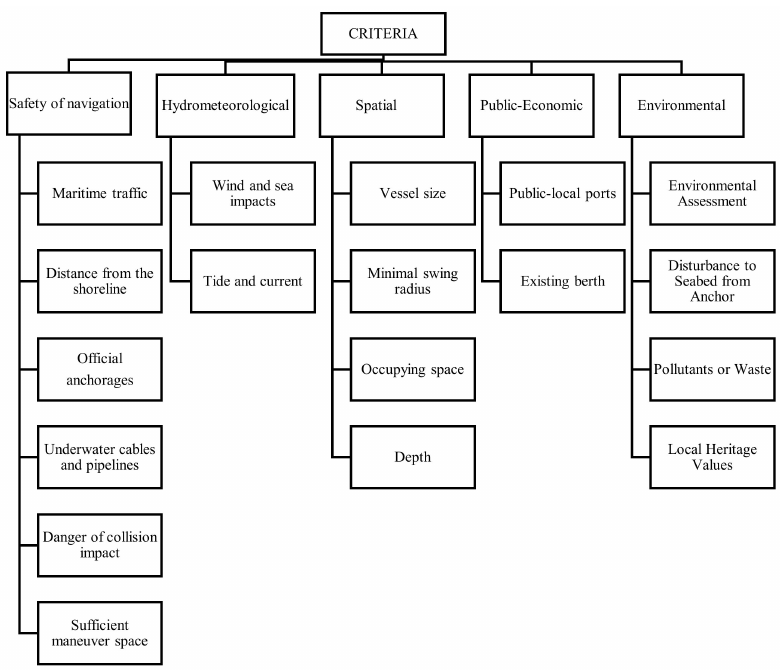
Figure 1. The most important criteria of nautical anchorages